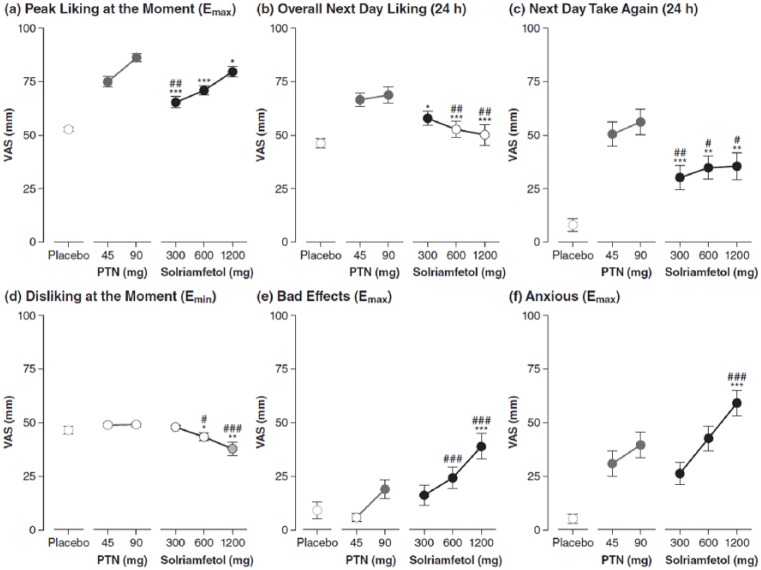
Perceptions of (a)–(c) positive and (d)–(f) negative drug effects.
(a)–(c) Filled circles indicate significant differences versus placebo
(p<0.05). The asterisk (*) and number (#)
symbols indicate significant differences versus PTN 90 mg and 45 mg,
respectively, with one, two, and three symbols corresponding to
p<0.05, p<0.01, and
p<0.001, respectively. Panels (a) and (b) are on
0–100 bipolar scales with 50 representing a neutral response. (d)–(f)
Filled circles indicate significant differences versus placebo
(p<0.05 solid fill; p=0.05 for
shaded fill). The asterisk (*) and number (#) symbols indicate
significant differences versus PTN 90 mg and 45 mg, respectively, with
one, two, and three symbols corresponding to p<0.05,
p<0.01, and p<0.001,
respectively. Data are mean ± standard error.Emax: peak effect;
Emin: lowest effect; PTN: phentermine;
VAS: visual analog scale